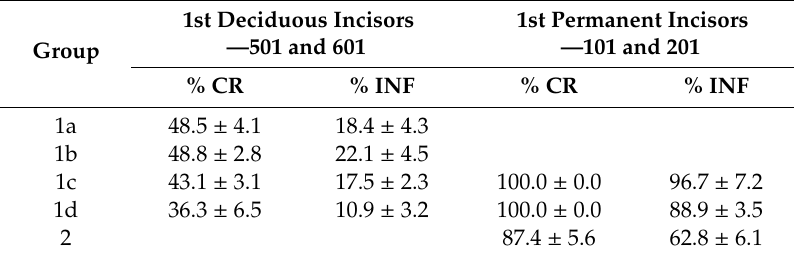
Table 3. Results (mean ± standard deviation) of relative lengths of the crown and infundibulum (% CR and % INF, respectively) of 1st deciduous incisors—501 and 601—and / or 1st permanent incisors—101 and 201—with respect to the total length of the tooth. Study of 25 horse skulls. 1st Deciduous Incisors 1st Permanent Incisors —501 and 601 —101 and 201 Group % CR % INF % CR % INF 48.5 ±